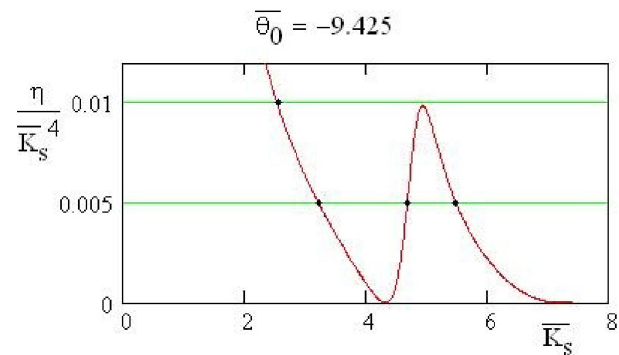
FIG. 12. (Color) Solutions of the steady-state oscillation condi- (cid:6) 1 (cid:4) =A (cid:1) 0 : 01 there is single stable solu- tion (55). For (cid:3) R (cid:6) 1 g rt (cid:6) 1 (cid:4) =A (cid:1) 0 : 005 the intersections correspond to tion. For (cid:3) R (cid:6) 1 g rt the two bistable solutions and a third unstable solution in